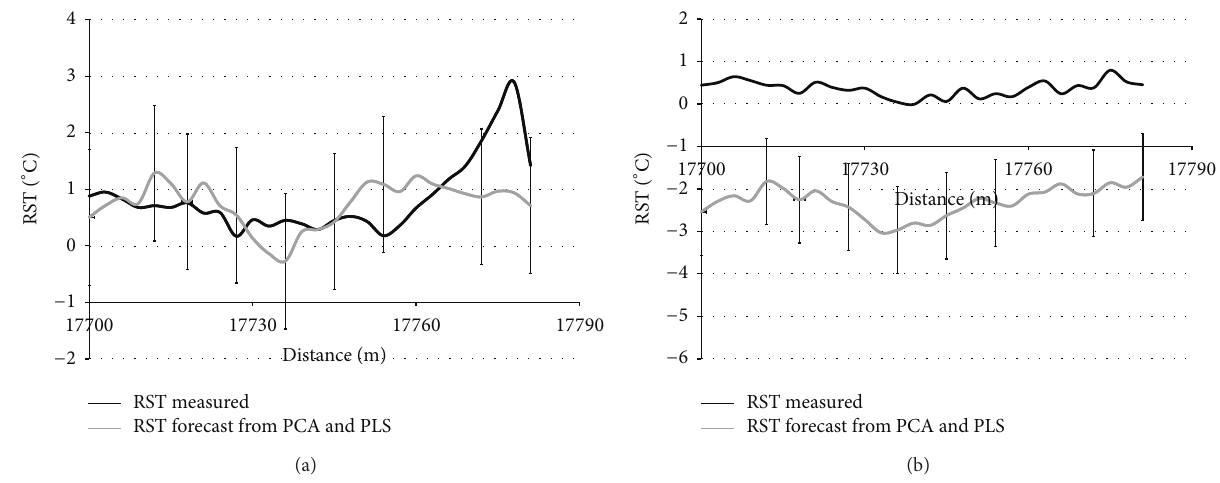
Figure 5: Comparison between measured RST and a RST forecast over a full urban stretch based on the combined use of PCA and PLS for two dates (2013-03-22 (a) and 2012-12-11